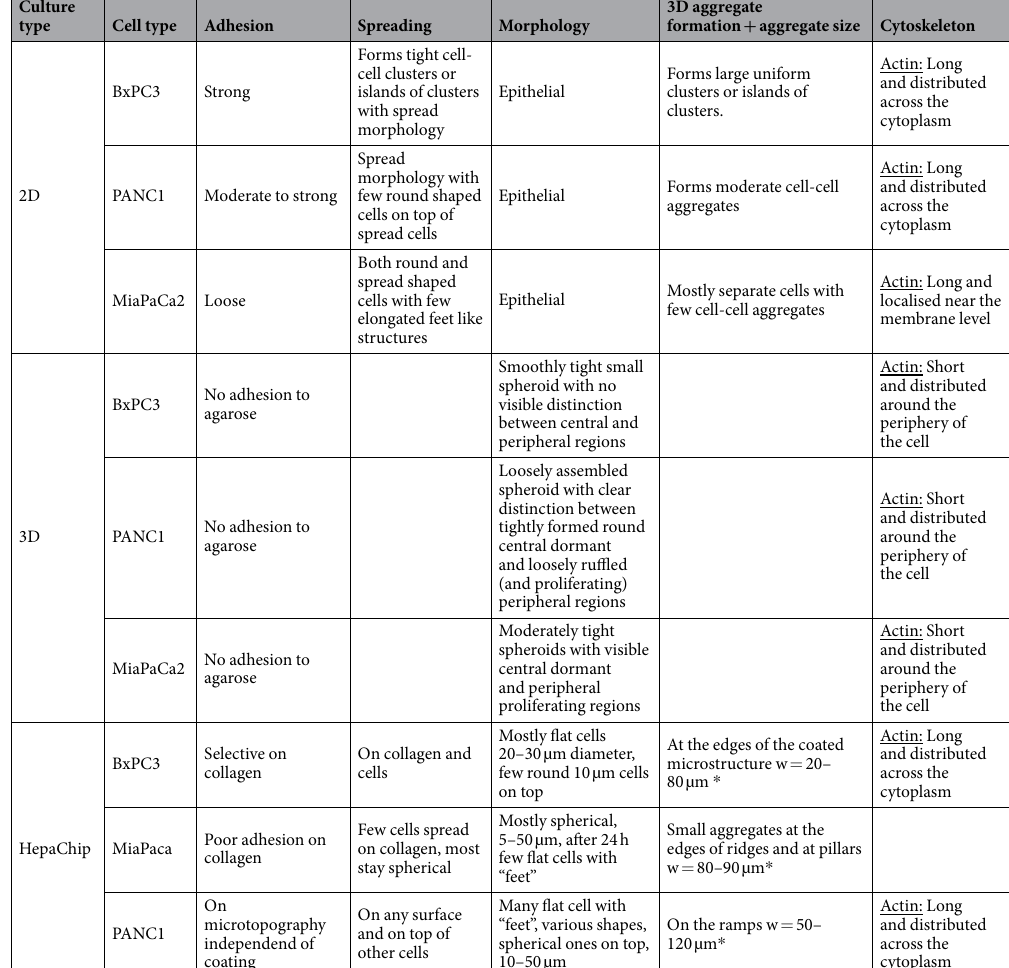
Table 1. Morphological and functional features of PDAC cells cultured in 2D, 3D and inside the microfluidics HepaChip device. * Maximum aggregate thickness in the HepaChip ® culture chamber was in the range of the measured width of the aggregates on the ramps. It is limited by the 3D geometry of the chamber between 40 µ m on the assembly ridges and 190 µ m inside the channels (see Fig. 3C) if assuming that at maximum aggregates can fill the height between the lid of the chamber and this ramp at the channel